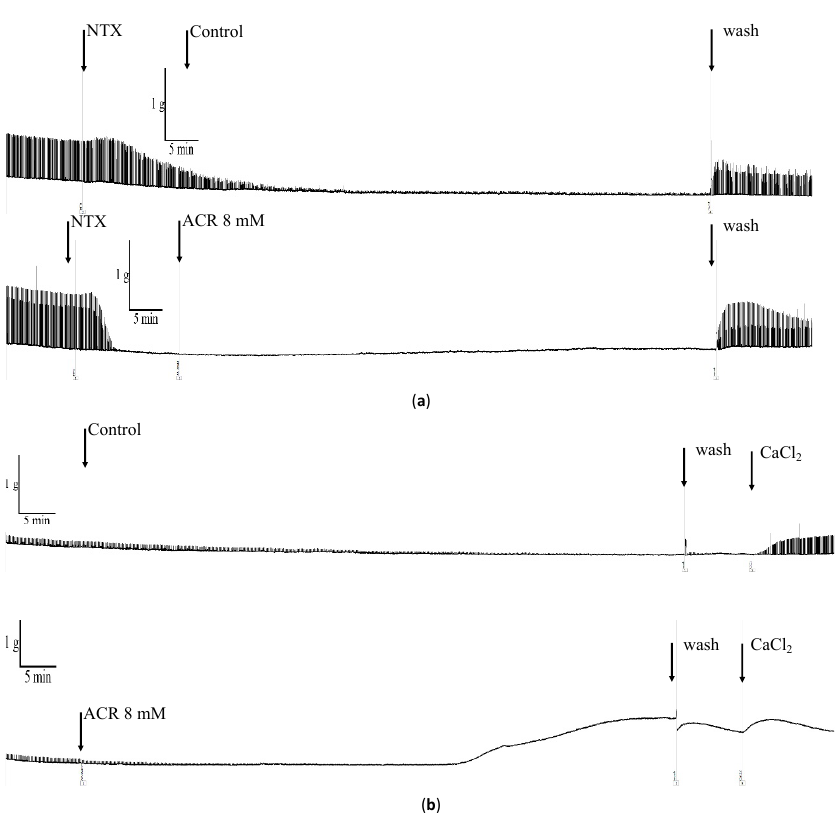
Figure 5. Effect of AChR inhibitor and Ca-chelating agent on isolated mouse phrenic nerve– diaphragm. ( a ) Effects of AChR inhibitor (NTX) on isolated mouse phrenic nerve–diaphragm.